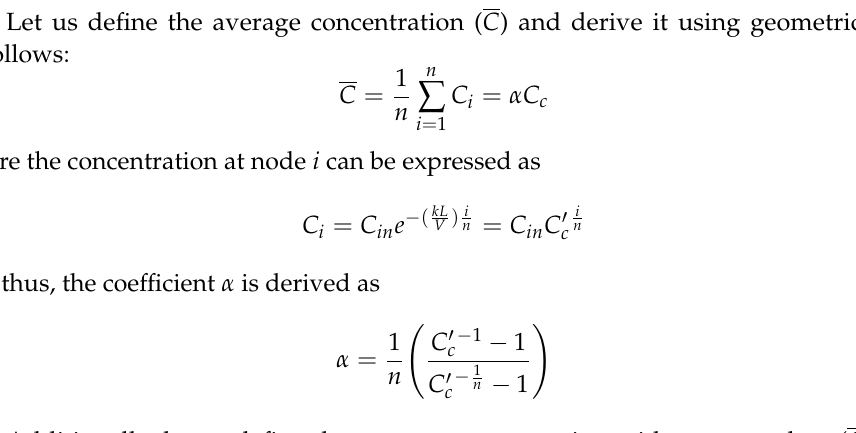
Figure 3. Disinfection concentration distribution for a single pipe network with multiple demands along the pipe, where ( a ) is with water loss and ( b ) is without water loss.